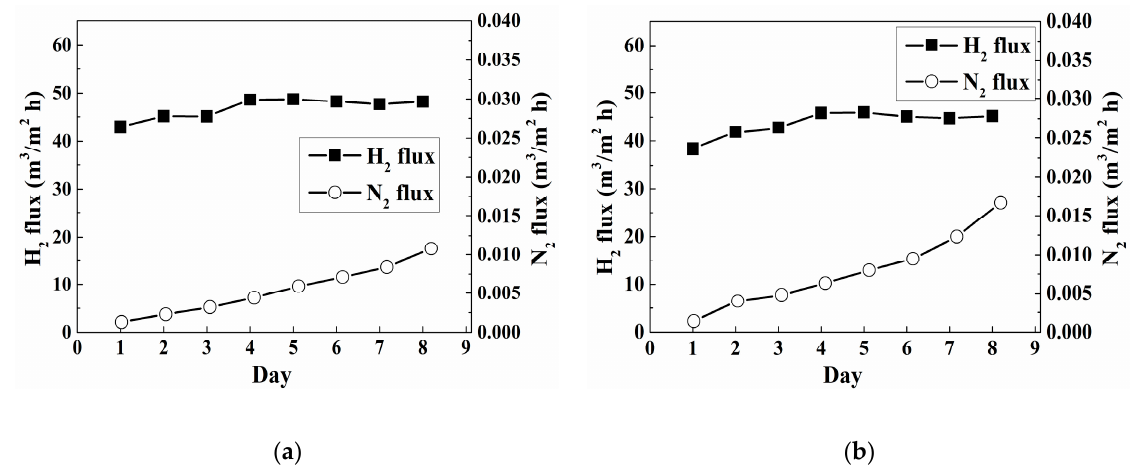
Figure 4. Thermal stability tests of the membranes were prepared using the same bath volume of 180 mL but different concentrations of hydrazine: ( a ) 6.75 mM; ( b ) 9 mM.